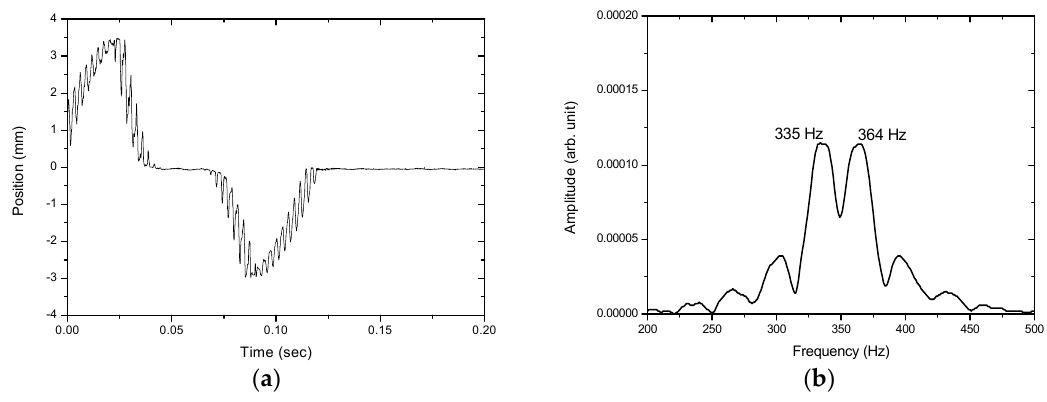
Figure 15. ( a ) The PSD-detected signal and ( b ) the frequency spectrum of the motion of the vibrating string at 6.3 × 10 − 2 m/s.